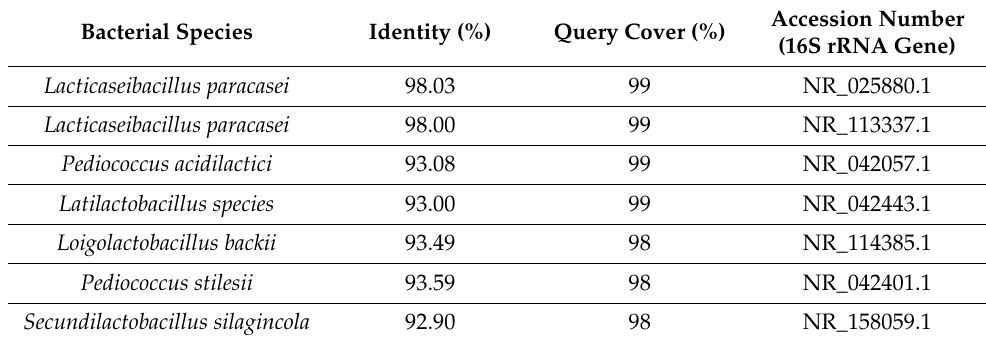
Figure 8. EDX spectra of anodic biofilm. Table 3. List of identified bacterial species from anode